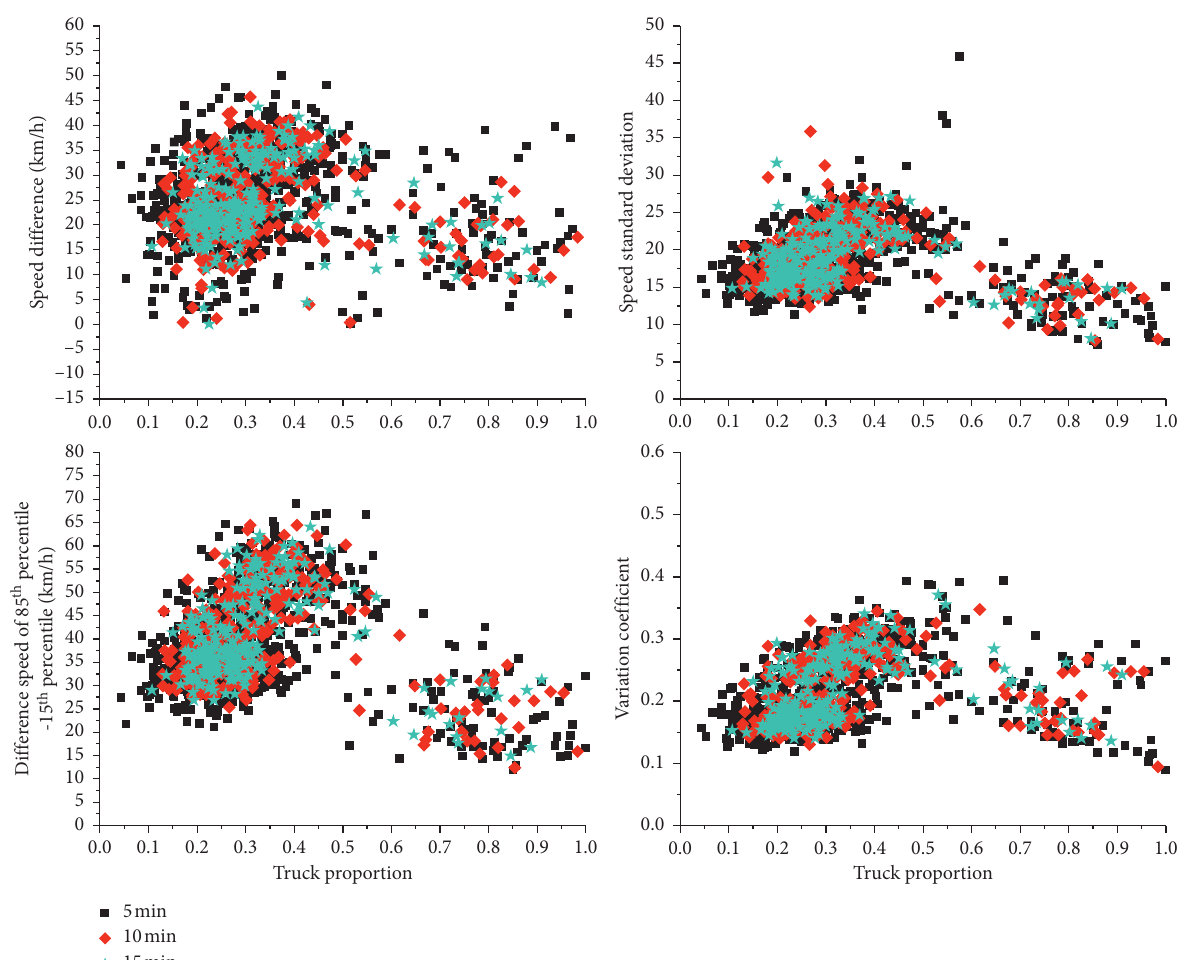
Figure 1: The relationship between truck proportion and traffic flow parameters in different